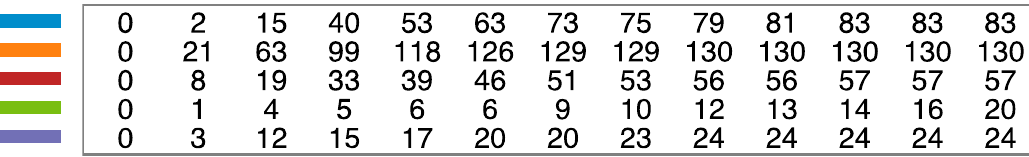
Figure 1. Probability of HIV infection over time of the placebo arms of the five PrEP studies. The Bangkok study’s follow up was until week 348. Vertical lines represent the censored individuals. Number at risk represents the number of individuals at HIV risk in each study at each time of the x-axis. Cumulative number of events represents the number of individuals who contracted HIV infection in each study at each time of the x-axis.